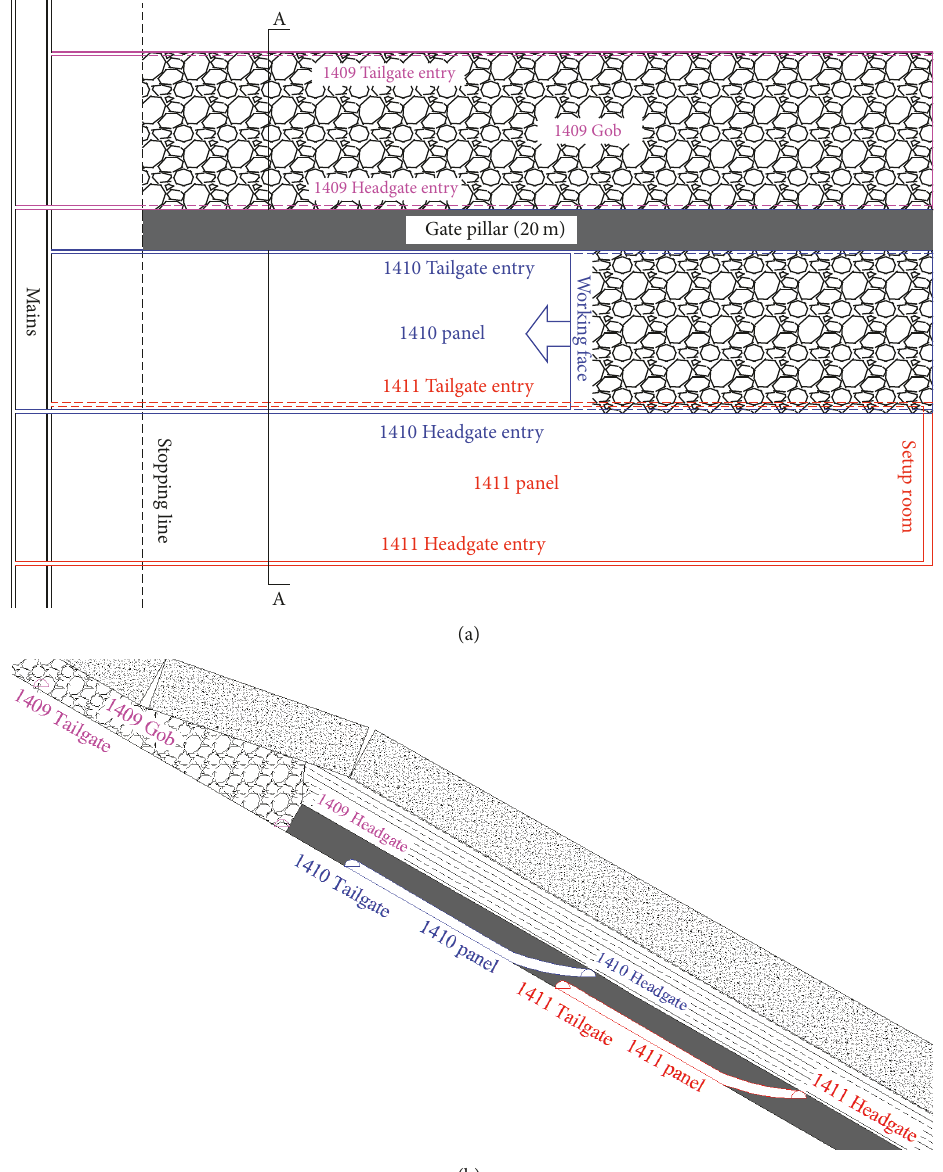
Figure 11: LMSG layout of 1409, 1410, and 1411 panel (not to scale). (a) Plan view, (b) A-A section